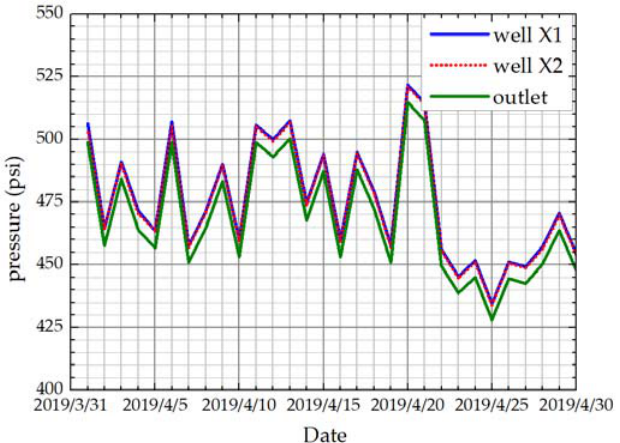
Figure 11. The outlet pressure and the wellhead pressure of these two wells of the 30 days.